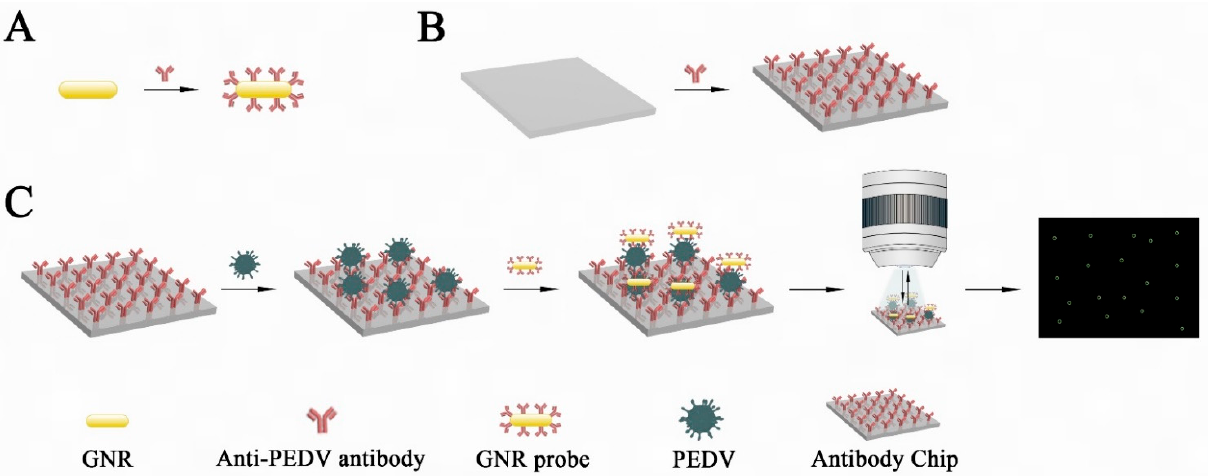
Figure 1. Scheme of GNR probe-assisted DFM counting chip. ( A ) Preparation of GNR probes. ( B ) Functionalization of the chip with antibodies for capturing PEDV. ( C ) Procedures for counting virus particles using GNR probe-assisted DFM counting chip. The capture chip was first functionalized with the antibody through chemical modification, followed by blocking with bovine serum albumin (BSA). In the presence of target viruses, the antibodies on the chip recognized the viruses to form sandwich structures with GNR probes. Each GNR probe of sandwiches presents green halo under DFM. The number of GNR probes can be counted readily.